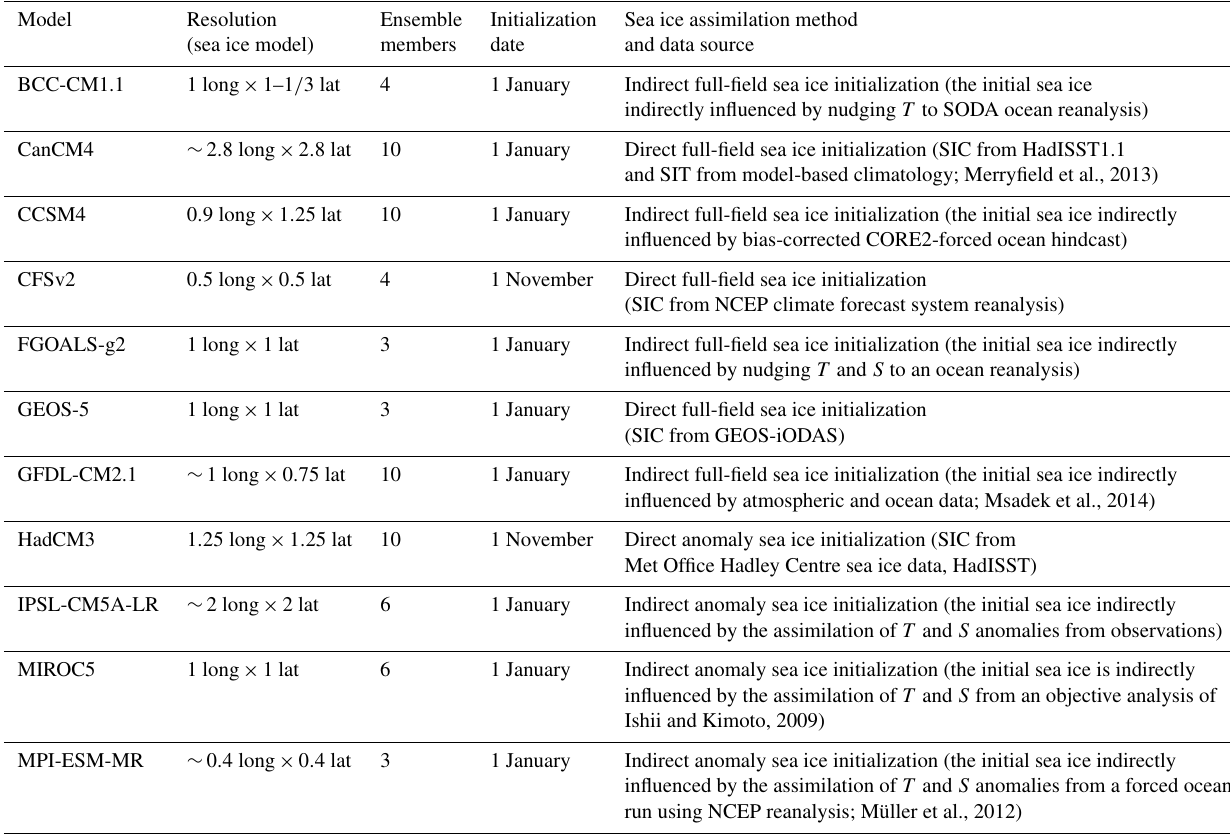
Table 1. Summary of initialization methods and data sources used for the CMIP5 decadal hindcast/prediction. Model